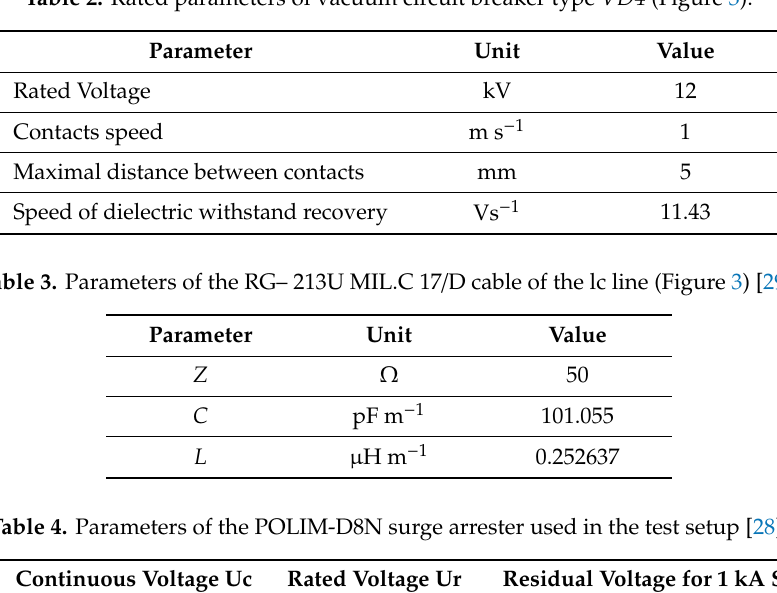
Table 2. Rated parameters of vacuum circuit breaker type VD4 (Figure 3).